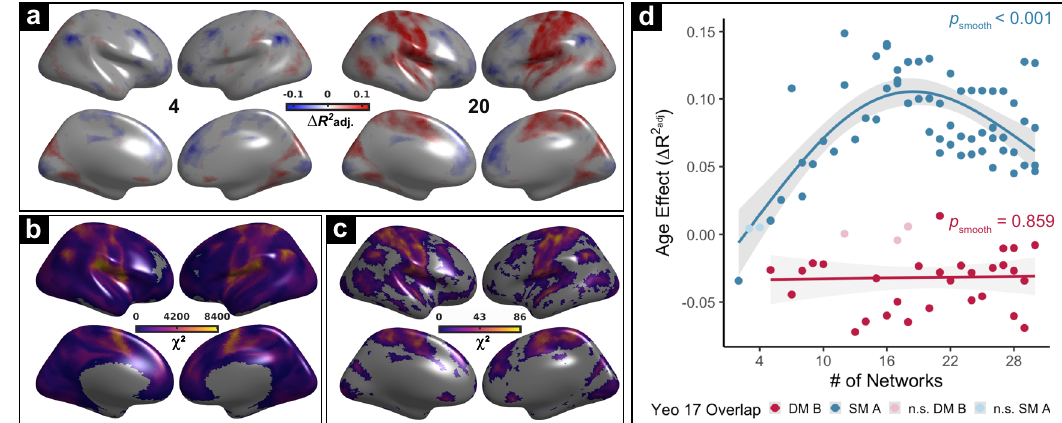
Fig. 5 The interactions between-network scale and developmental coupling is maximal in sensorimotor cortex. a The effect of age on average vertex- wise between-network coupling at two scales (4 and 20). Age effects are modeled using GAMs with penalized splines; thresholded at Q FDR < 0.05. Scale- dependent age effects can be observed in sensorimotor cortex: while no developmental increase in between-network coupling was seen in somatomotor cortex at scale 4, such an increase is evident at scale 20. b Across ages, between-network coupling of the sensorimotor cortex is strongly in fl uenced by scale. Generalized estimating equations (GEEs) reveal that the effect of scale ( χ 2 ) differentially in fl uences the strength of between-network coupling across the cortex. Locations within unimodal sensorimotor cortex exhibit the strongest scale-dependence in their mean between-network coupling ( Q FDR < 0.05). c Scale differentially interacts with age-dependent developmental associations with coupling across the cortex. GEEs are used to examine the degree of scale-moderated developmental effects (age-by-scale interaction; thresholded at Q < 0.05); maximal effects are present in the sensorimotor cortex. d Scale differentially interacts with age-dependent developmental effects in sensorimotor and association networks. Speci fi cally, age effects in lower-order networks tend to be more scale-dependent than those in higher-order networks. The effect of age across scales is plotted for networks predominantly overlapping with the lowest-order (blue; Somatomotor-A) and highest-order (red; Default Mode-B) networks, as quanti fi ed from the functional hierarchy. Statistical tests are two-sided. Error bands depict the 95% con fi dence